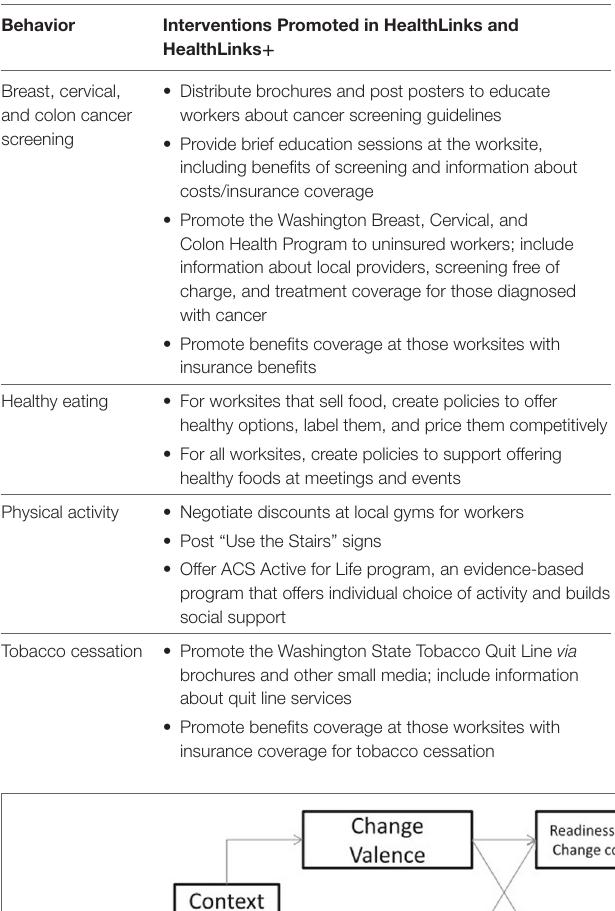
Table 1 | Evidence-based health promotion practices to be implemented as part of HealthLinks. behavior interventions Promoted in healthlinks and healthlinks + Breast, cervical, and colon cancer